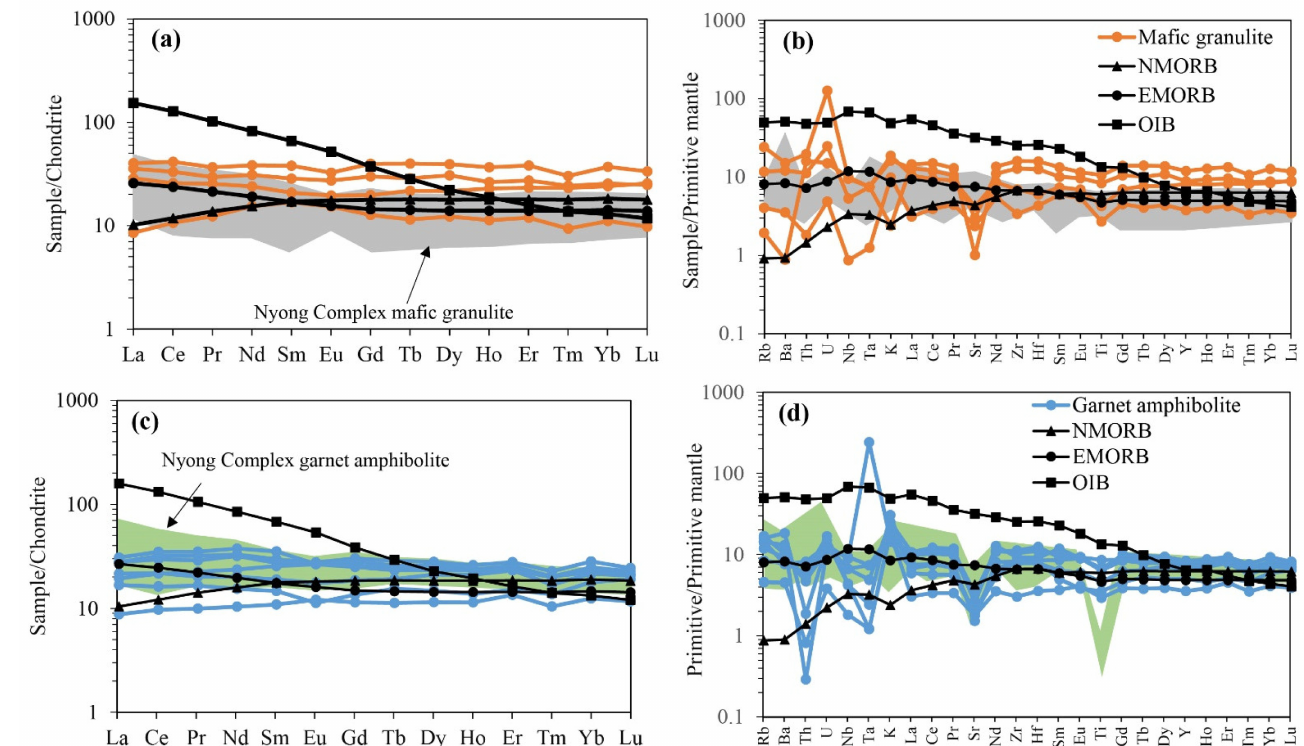
Figure 8. ( a , c ) Chondrite-normalized (normalization values after [55] REE plots for the Anyouzok mafic granulite and garnet amphibolite, respectively); ( b , d ) primitive mantle-normalized (normaliza- tion values after [52] multielement diagrams for the Anyouzok mafic granulite and garnet amphibolite garnet amphibolite, respectively). Nyong Complex mafic granulite data are from [11,31]. Nyong Complex garnet amphibolite data are from